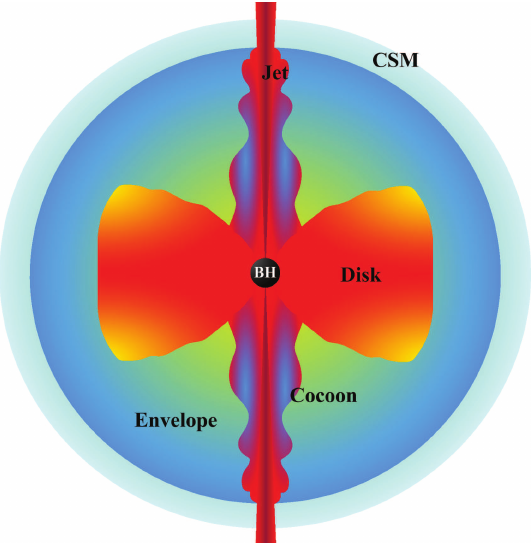
Figure 1. Schematic picture of a BH hyperaccretion in the center of a